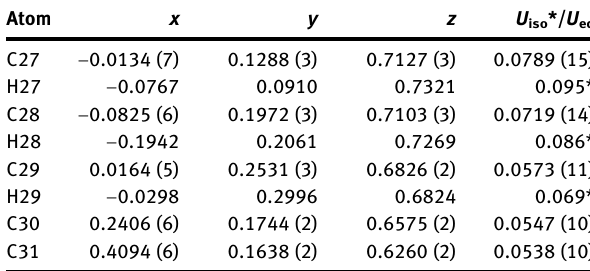
Table  : Fractional atomic coordinates and isotropic or equivalent isotropic displacement parameters (Å 